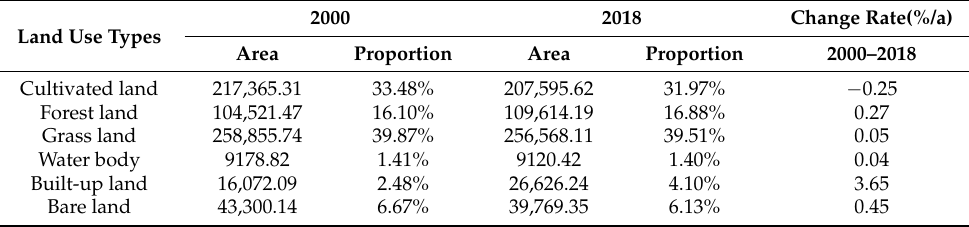
Table 1. Statistical table of the percentage and area of land use types in the Loess Plateau (unit: km 2 ). Land Use